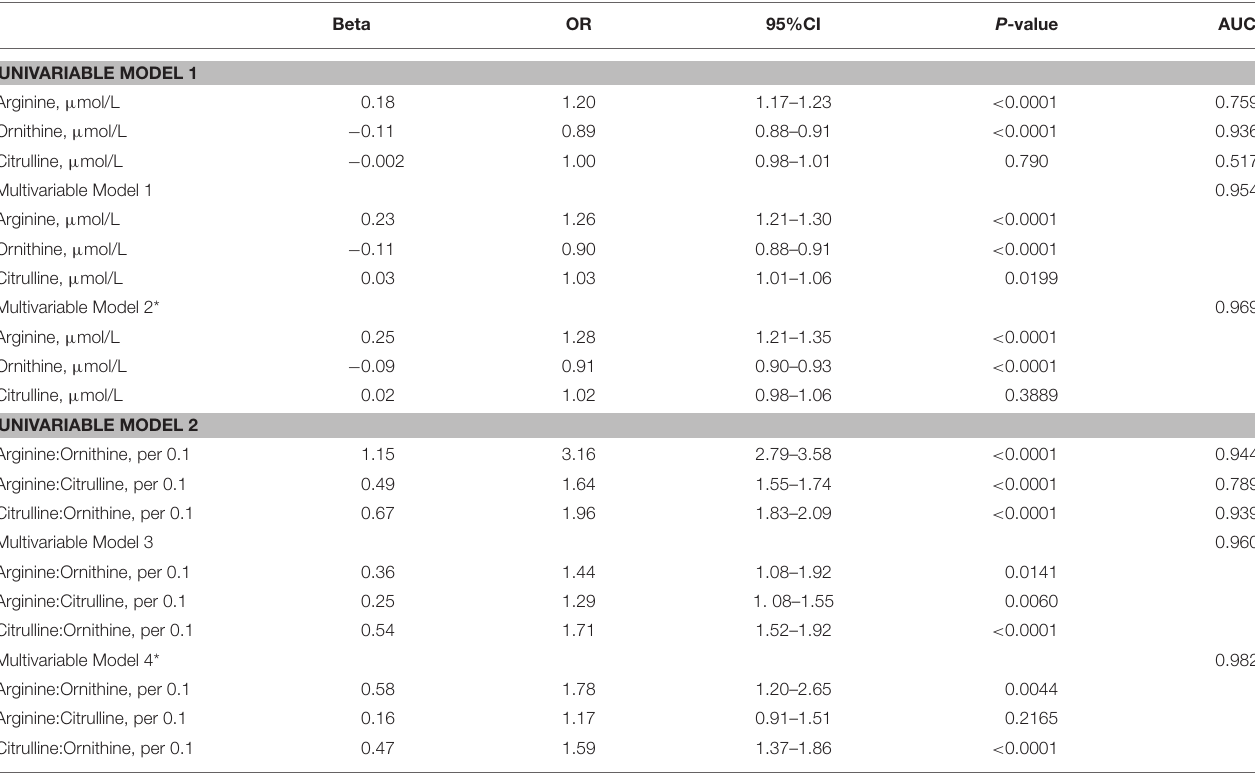
TABLE 2 | Odds ratio of amino acids and ratios of amino acids for the risk of type 2 diabetes mellitus. Beta OR 95%CI P -value